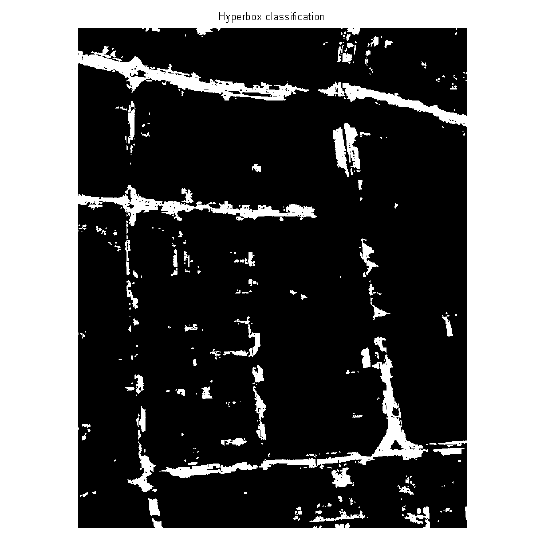
Figure 4. Result of the segmentation by the hyperbox